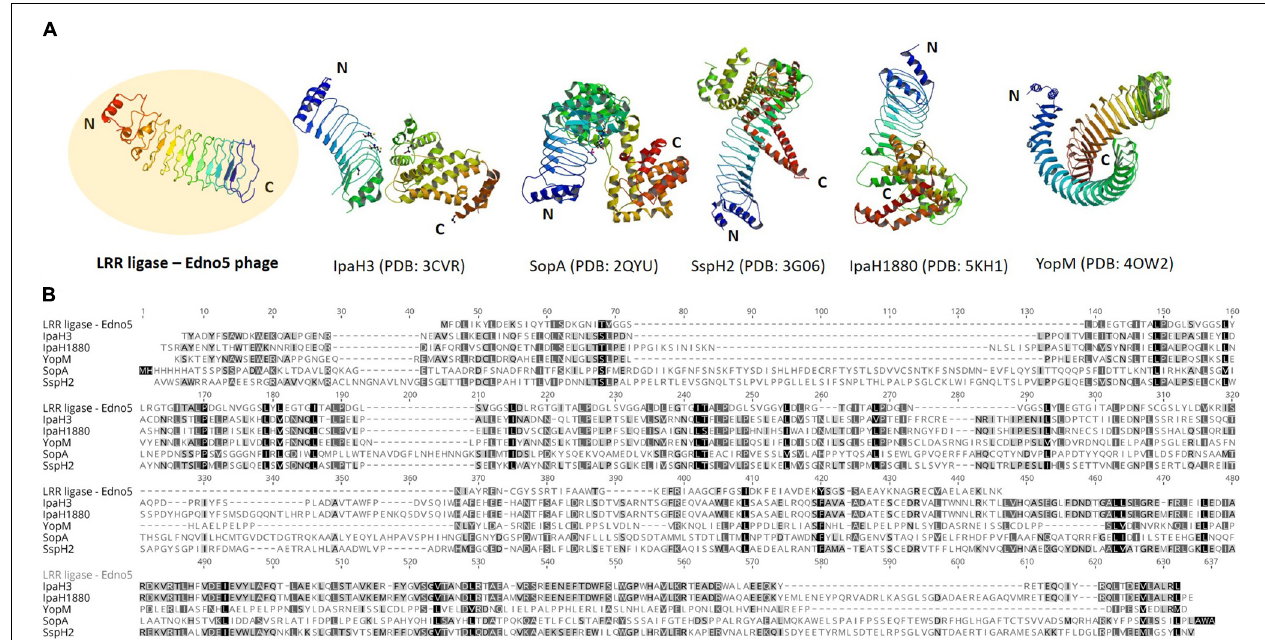
FIGURE 3 | (A) Protein structure of LRR ligase encoded by Edno5 in comparison with 5 confirmed LRR-containing toxins from pathogenic Enterobacteria: IpaH3 (PDB: 3CVR) and IpaH1880 (PDB: 5KHI) from Shigella flexneri , SopA (PDB:2QYU) and SspH2 (PDB: 3G06) from Salmonella enterica ser. Typhimurium and YopM (PDB: 4OW2) from Yersinia enterocolitica , (B) Multiple alignment of the aa sequence of Edno5 LRR ligase with the 5 confirmed toxins, demonstrating in all of them the conserved LRR pattern.